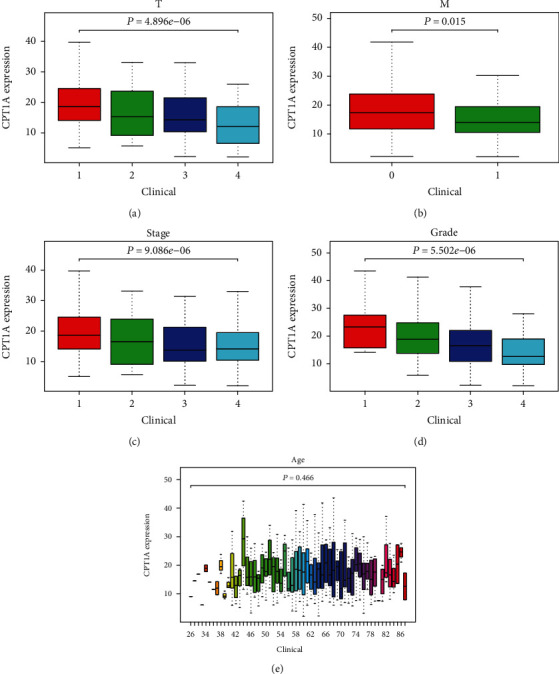
The relationship between the expression of CPT1A and various clinicopathological parameters in KIRC patients. (a) Tumor. (b) Metastasis. (c) Stage. (d) Grade. (e) Age.